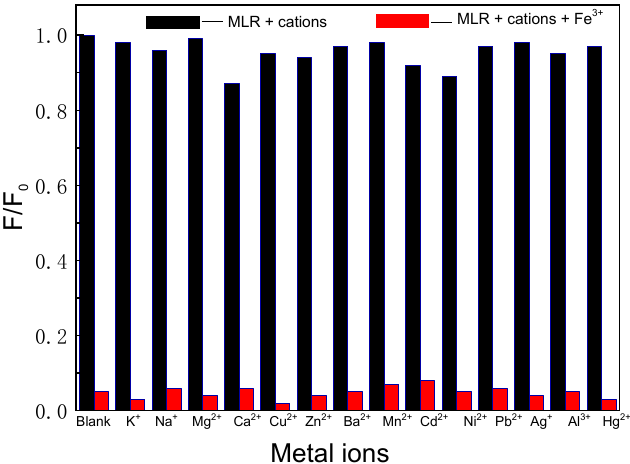
Figure 5. Fluorescence decreases at 400 nm of MLR (2.0 μ M) in the presence of different metal ions (20 equiv.) (black); the fluorescence spectra changes of MLR (2.0 μ M) with the addition of the metal ions mixture and 40 μ M Fe 3+ ions